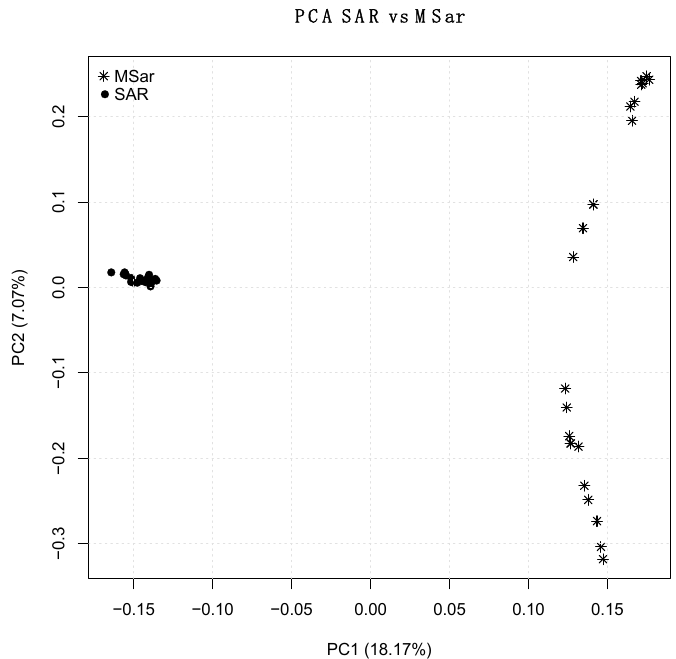
Figure 1. Principal Components Analysis (PC1 vs. PC2) of the two reference populations (MSar and SAR) analysed using the full single nucleotide polymorphism (SNP) set. In brackets are the percentage of variance explained by each component.